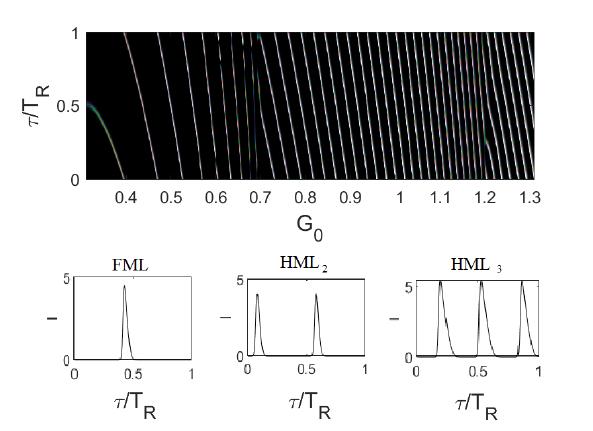
Figure 2. Example of transition from fundamental modelocking (FML) to harmonic modelocking with two pulses (HML 2 ) and harmonic modelocking with three pulses (HML 3